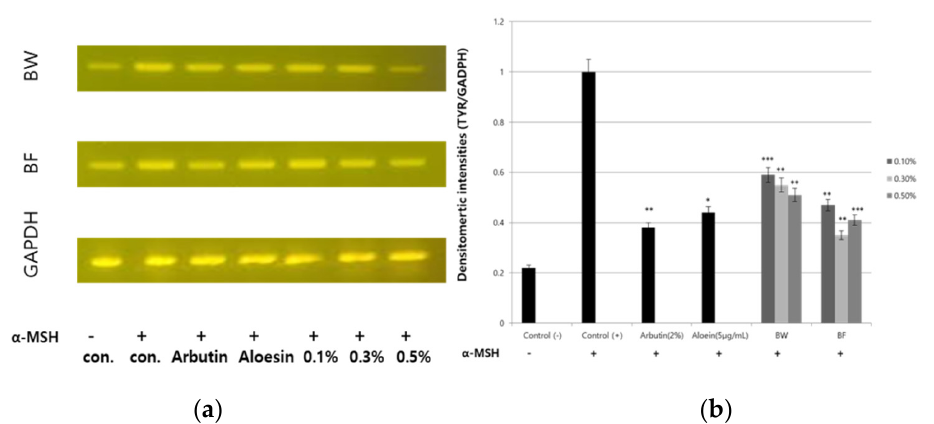
Figure 9. Downregulation of mRNA expression of TYR from α -MSH treated B16F10 cells ( a ) and relative densitometric intensities corresponding to each PCR band normalized with a house keeping gene, GAPDH ( b ) in treating various concentrations of two extracts of aloe skin leaf, and 5 µ g/mL aloesin and 2% arbutin as positive controls. BW: Water extract of aloe skin leaf at 100 ◦ C for 24 h. BF: Fermented extract of aloe skin leaf fermented with L. plantarum BN41 at 37 ◦ C for 3 days and further extracted by an ultrasound generator at 20 kHz for 4 h. The mean values ± SD for separate triplicate experiments are shown, and error bars indicate the SD. The significance of the difference was set to * p < 0.05, ** p < 0.01 and *** p < 0.001 compared with the control (+).